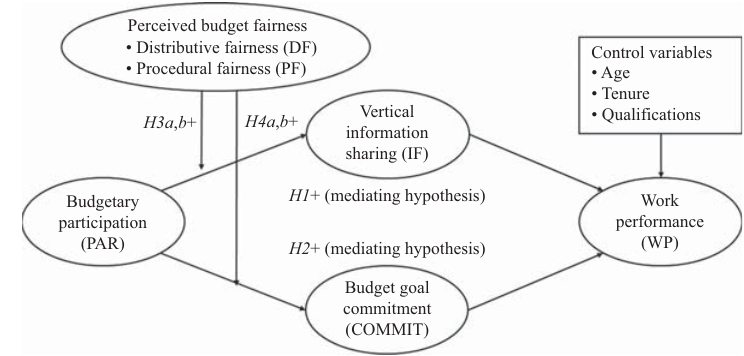
Figure 1. Proposed